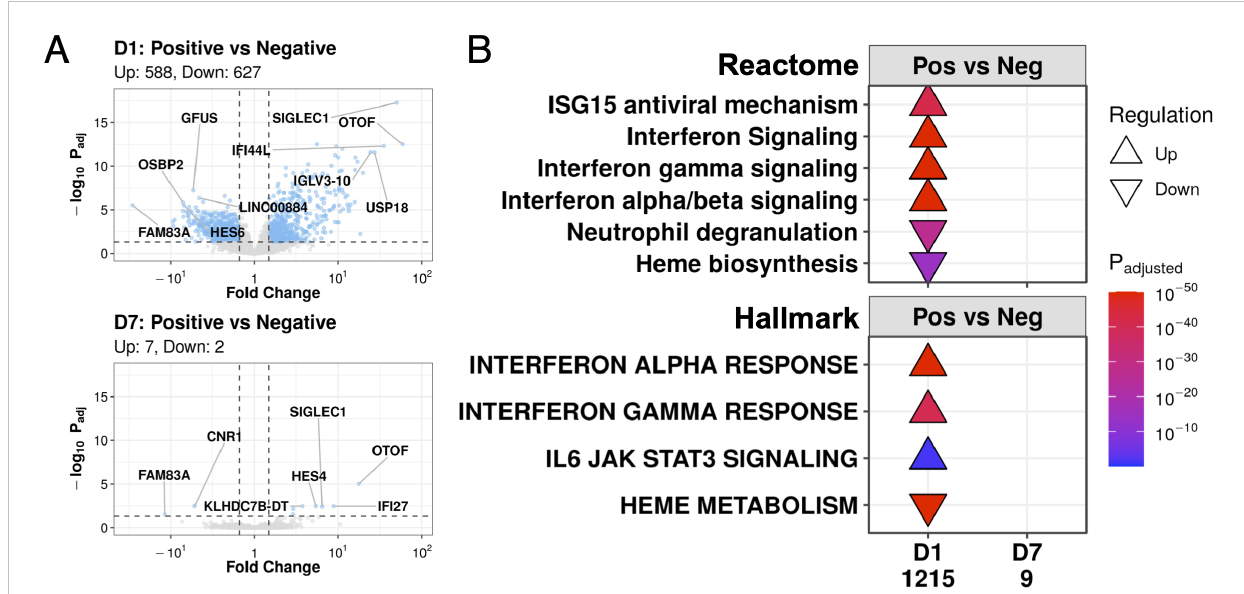
FIGURE 3 COVID-19 and non-COVID-19 sepsis patients differed at D1 but converged to nearly identical transcriptional pro fi les at D7. (A) Volcano plots of genes differentially expressed (DE) between COVID-19 (Positive) and non-COVID-19 sepsis (Negative) patients at D1 (top) and D7 (bottom). Coloured dots represent DE genes (absolute fold change ≥ 1.5, adjusted P-value <0.05; cut-offs indicated by dotted lines). The top 5 up- and down- regulated annotated genes (lowest adjusted p-value and highest fold change) are labelled. (B) Subset of enriched Reactome pathways (top) and Hallmark gene sets (bottom) using DE genes between COVID-19 (Pos) and non-COVID-19 sepsis (Neg) patients at D1 and D7, with all enriched pathways shown in Figures S3, S4. No pathways were enriched amongst the 9 DE genes at D7. “ Upregulated ” pathways/gene sets ( D ) had genes that were overrepresented in upregulated DE genes when compared to their prevalence in the genome, suggesting an increase in their function or activity, and vice versa for “ downregulated ” pathways/gene sets ( ∇ ). The total number of DE genes in each comparison are shown under each